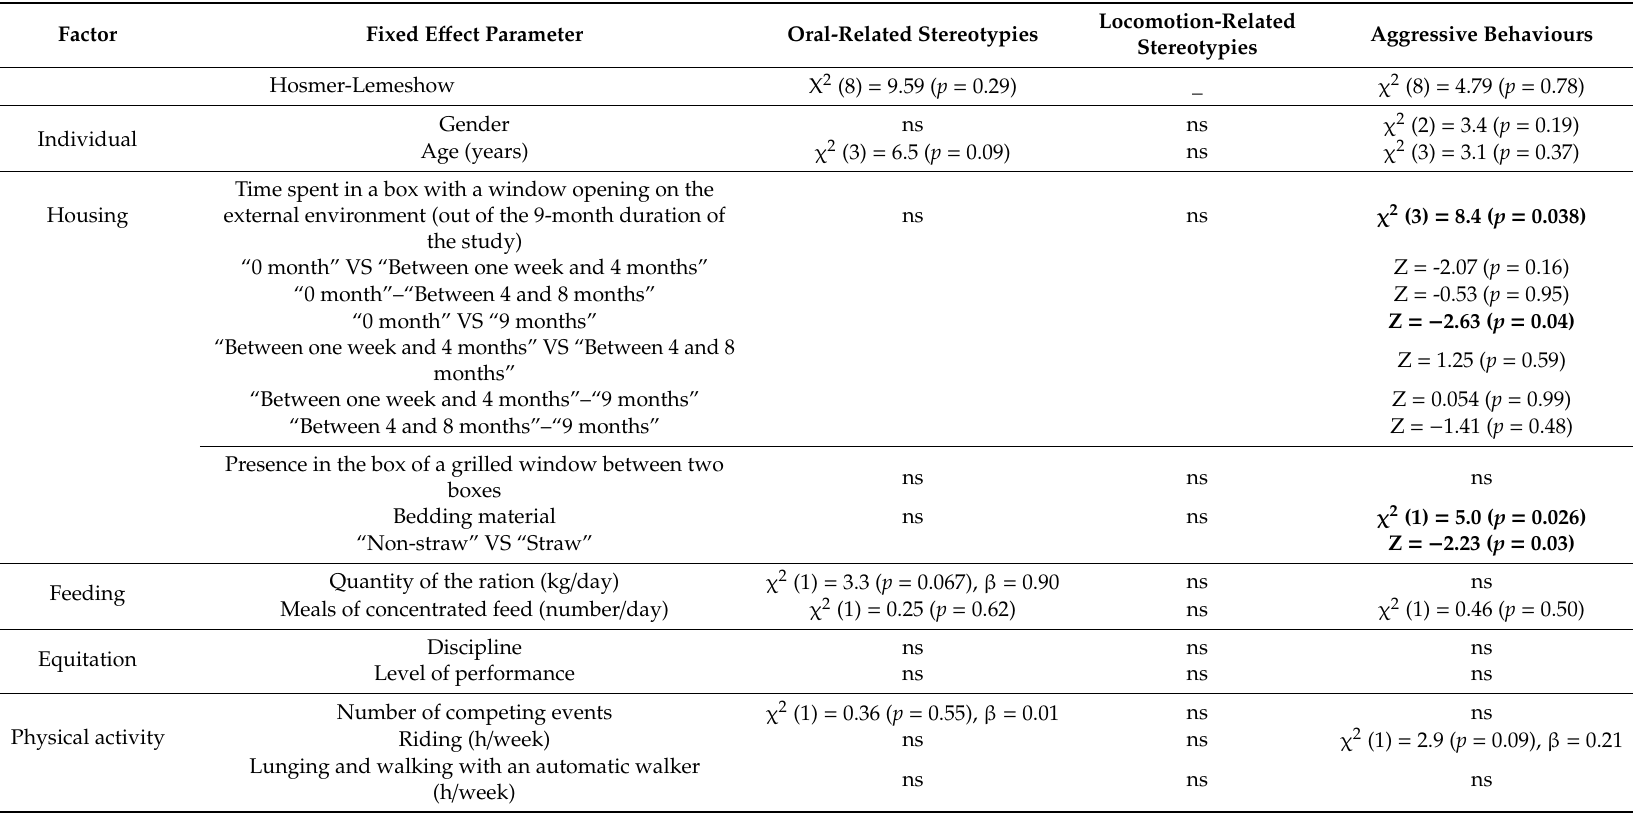
Table 6. Fixed e ff ect parameters kept to build final models of oral and locomotion-related stereotypies and aggressive behaviours after univariate analysis generalized linear mixed models (GLMMs) fitted with binomial error distribution and Laplace approximation). The goodness-of-fit of each model was assessed using the Hosmer-Lemeshow χ 2 test. Gender and age were controlled for as confounding factors. The results of Wald χ 2 tests and Tukey post hoc tests (Z values) are presented along with p -values ( p ). Regression coe ffi cients ( β ) of the model are presented for continuous variables. Values in bold represent significant parameters with